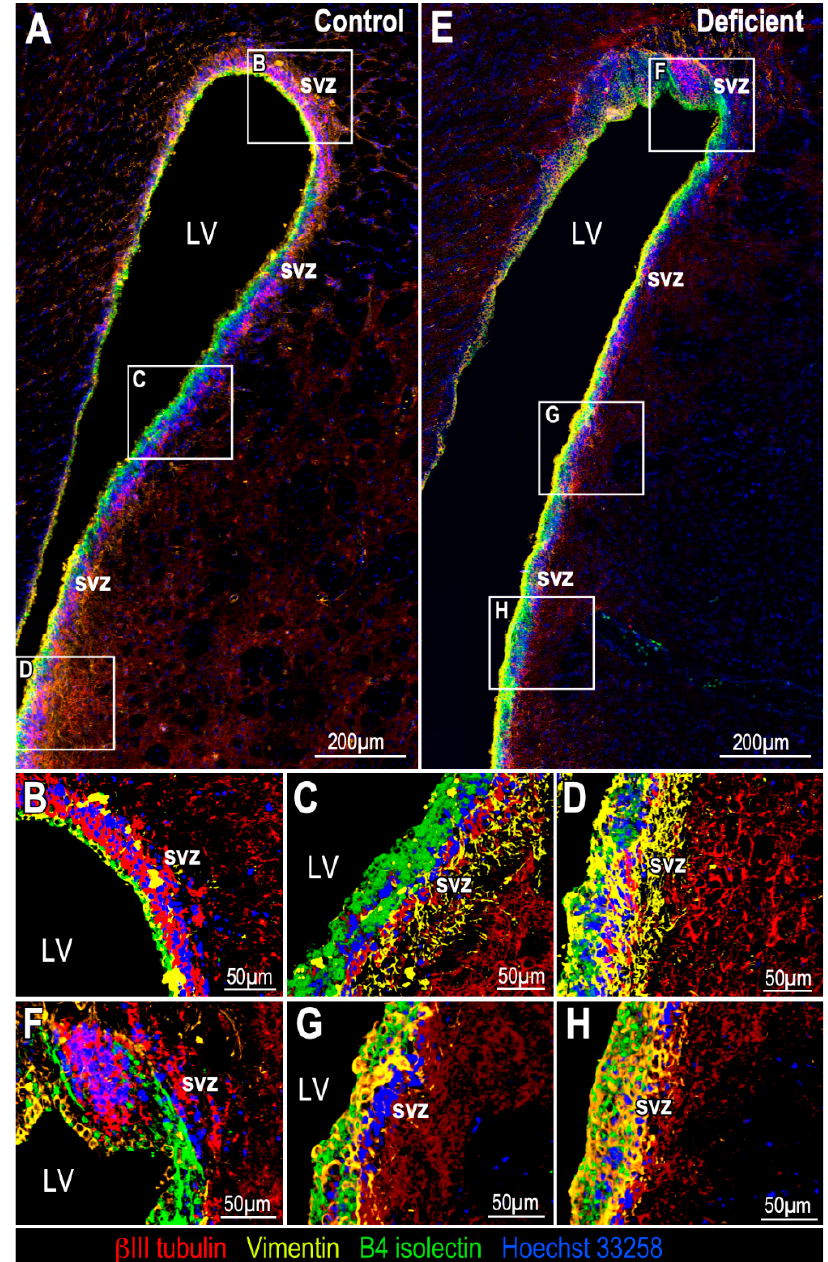
Figure 4. Multi-labeling analysis of neuronal and glial distribution in the SVZ of adult vitamin-C- deficient guinea pigs. Z-stacks projections, 3D reconstruction and tile scanning, using multiple markers: anti- β III tubulin (1:1000, red), anti-vimentin (1:100, yellow), B4 isolectin (1:10, green) and Hoechst 33258 (1:1000, blue). ( A ) Glial and neuronal distribution in the SVZ of control guinea pigs. ( B – D ) Higher magnification of dorsal ( B ), medial ( C ) and ventral ( D ) areas of the LV in image A. ( E ) Glial and neuronal distribution in the SVZ of guinea pigs with 21 days of vitamin C deficiency. ( F – H ) Higher magnification of dorsal ( F ), medial ( G ) and ventral ( H ) area of the LV in image E; distribution of glial cells was different and the amount of neuroblasts (red) was lower along the LV of vitamin-C-deficient guinea pigs regarding control animals. LV: lateral ventricle. SVZ: subventric- ular zone.